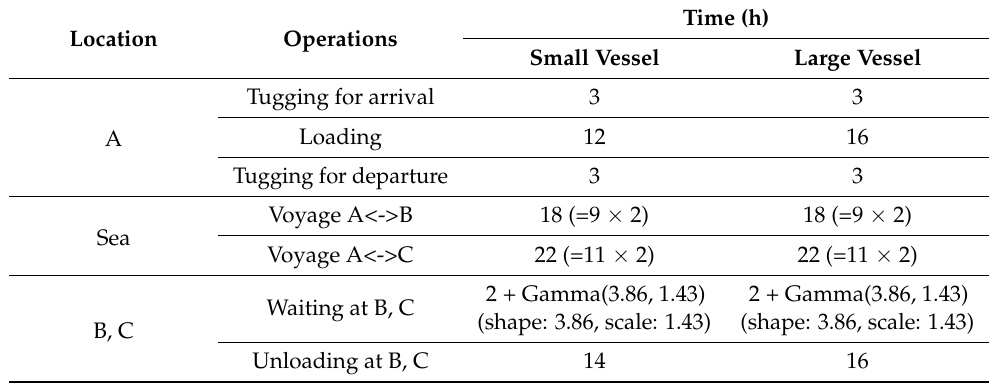
Table 3. Time duration for operations.